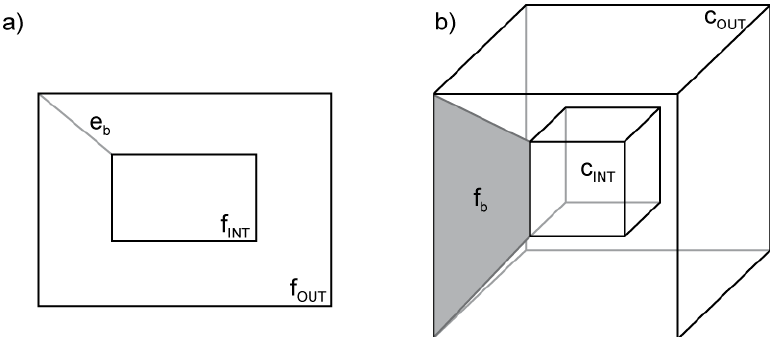
Figure 4. Holes and cavities: ( a ) hole in a face-bridge edge e b connects internal face loop f INT with the outside loop f OUT ; ( b ) cavity in a cell-bridge face f b connects internal cell c INT with the outside cell c OUT